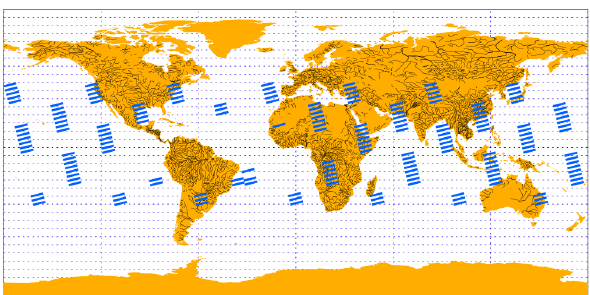
Figure 1. Geographical location and coverage of nighttime limb- emission observations performed by SCIAMACHY on 9 Septem- ber 2010 in the dedicated mesosphere/thermosphere mode.